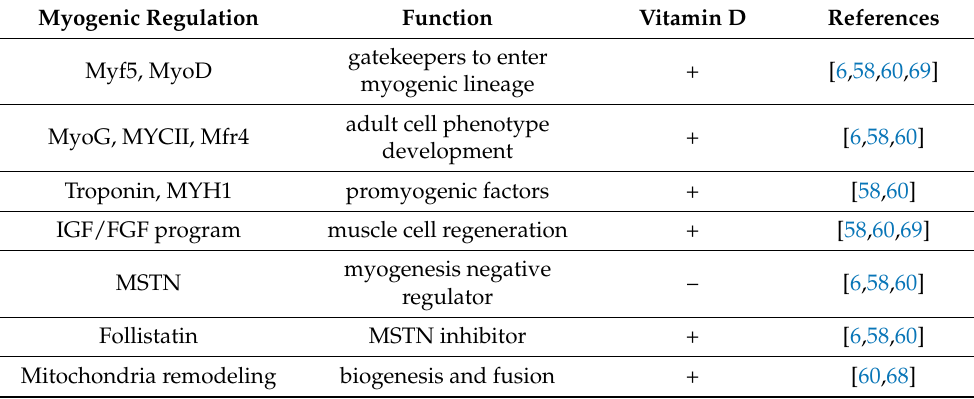
Table 1. Vitamin D enhances cell remodeling and myogenic program. Adequate levels of vitamin D support skeletal muscle cell remodeling and myogenic programming, pushing towards